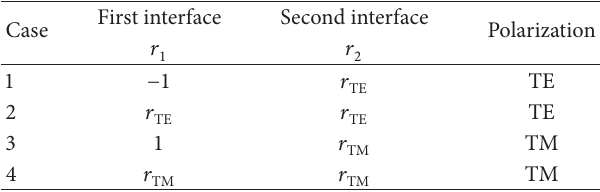
Table 1: Notations for the four cases